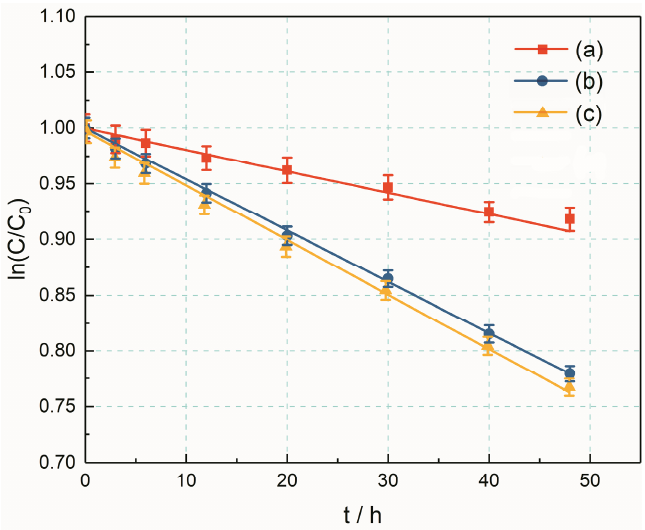
Figure 5. Photocatalytic activity in decomposing methylene blue of TiO 2 coatings: ( a ) TiO 2 ‐ 12 ‐ 0, ( b ) TiO 2 ‐ 12 ‐ 30, and ( c ) TiO 2 ‐ 20 ‐ 30.